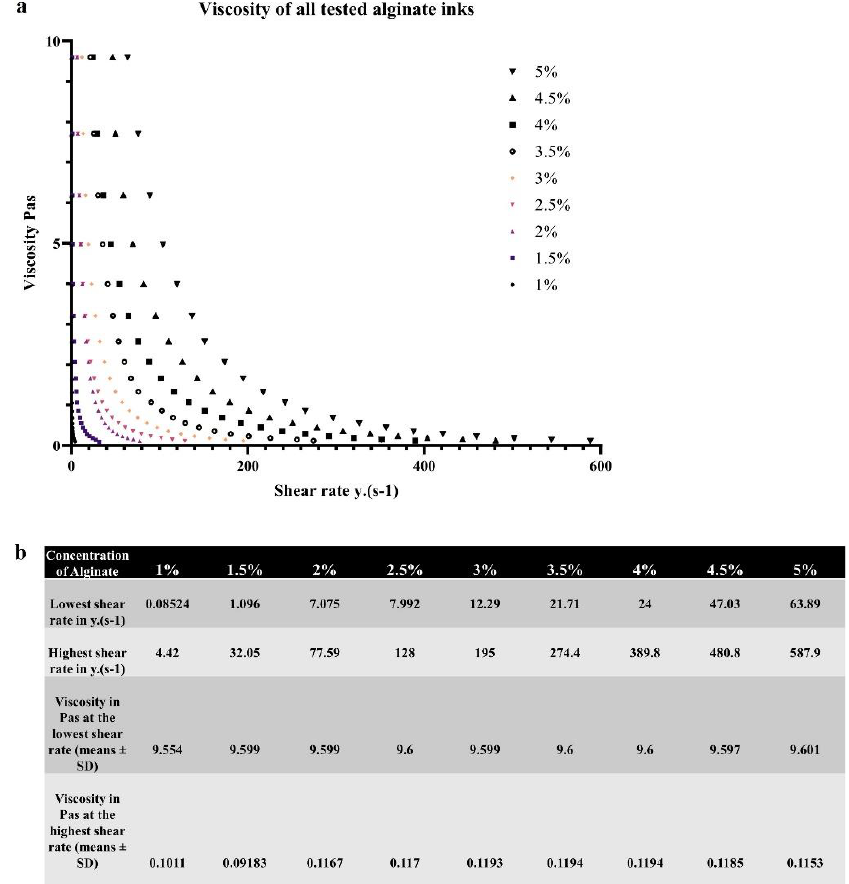
Figure 3. Assessment of viscosity of different bioink formulations. ( a ) Illustrates the dynamic vis- cosity of different bioink formulations across a range of shear rates. Figure legend corresponds to percentages of different alginates tested. ( b ) Displays the data from ( a ) in a table for easier compar- ison.